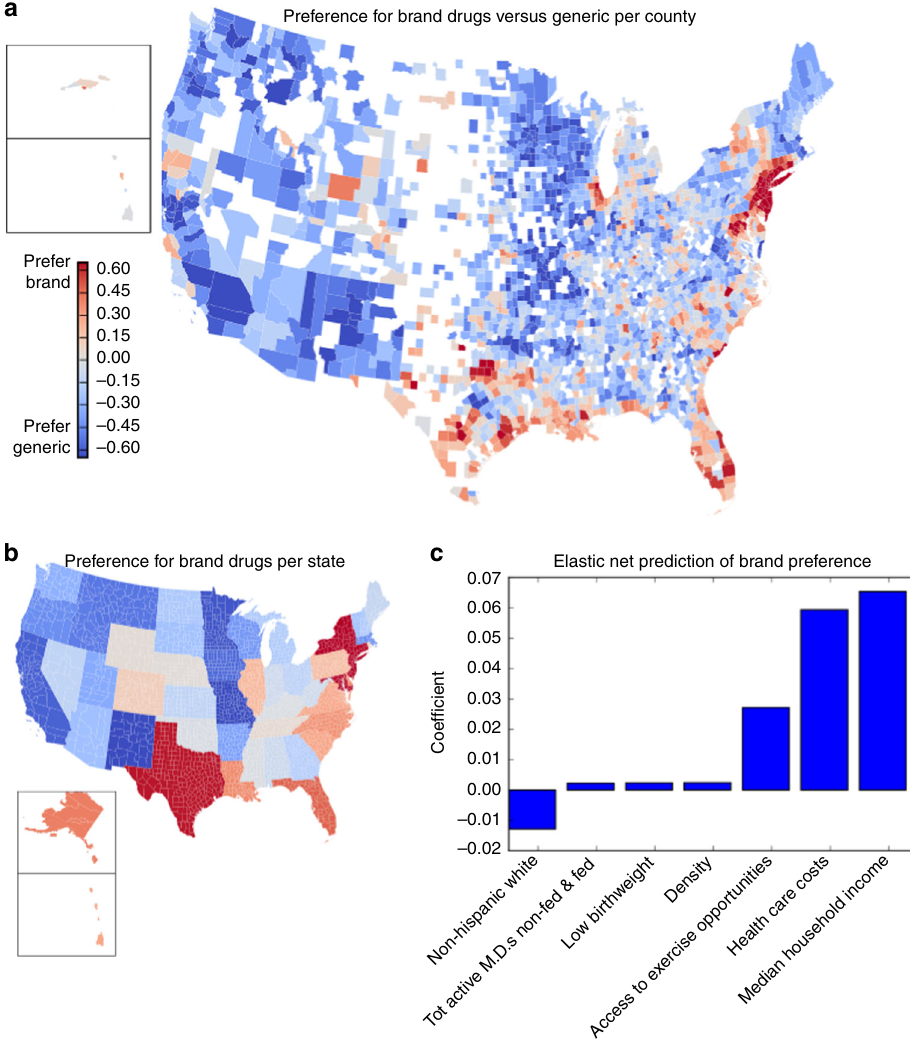
Fig. 6 Estimation of brand preference per county and state. a We plot the regression coef fi cients for brand preference per county. Positive coef fi cients imply a preference for brand drugs, and against generic drugs. b The same, for states. c Comparison of county brand preference against demographic characteristics, using an elastic net regression model to predict brand